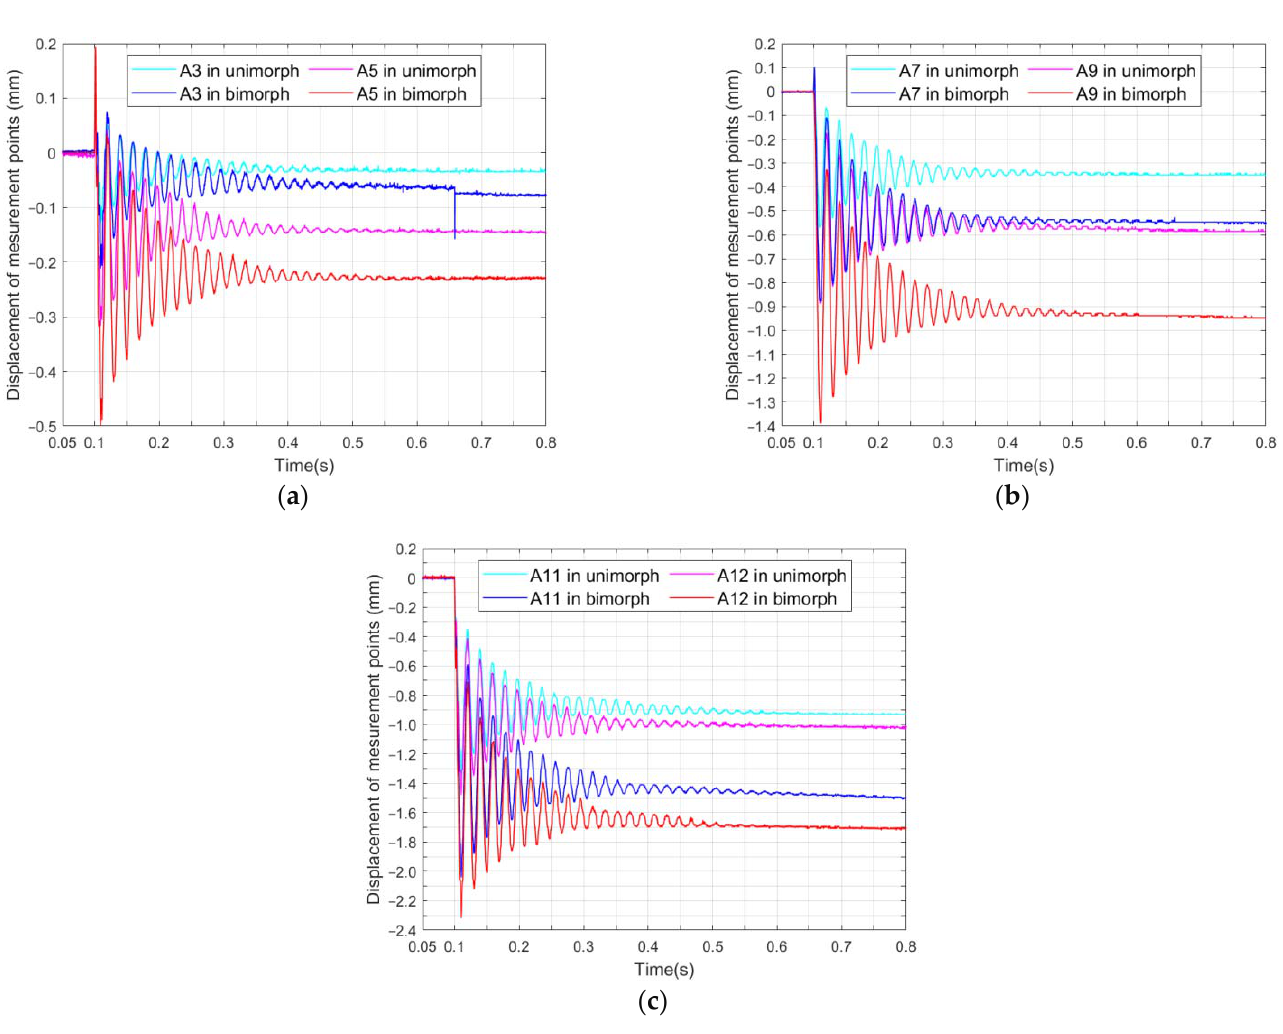
( a ) for points: A3 and A5; ( b ) for points: A7 and A9; ( c ) for points: A11 and A12.